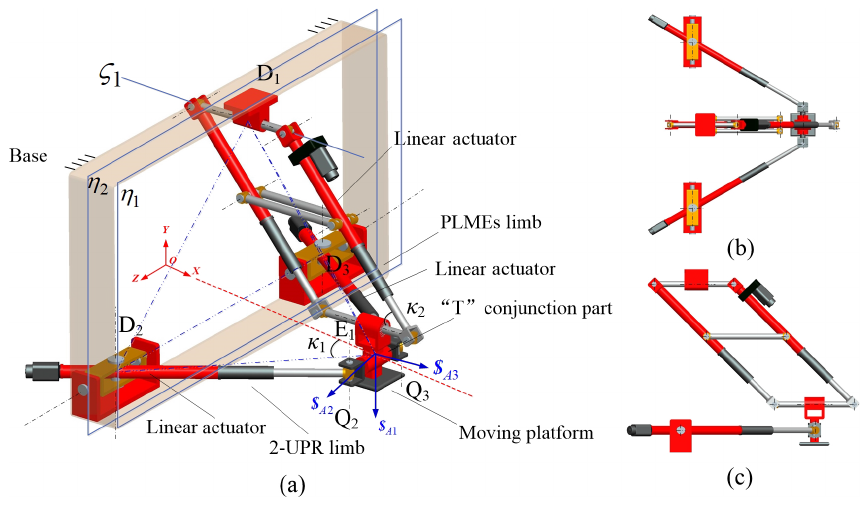
Figure 1. A 3-DoF translational manipulator with PLMEs limb and single loop 2-UPR: (a) oblique view, (b) top view, (c) side